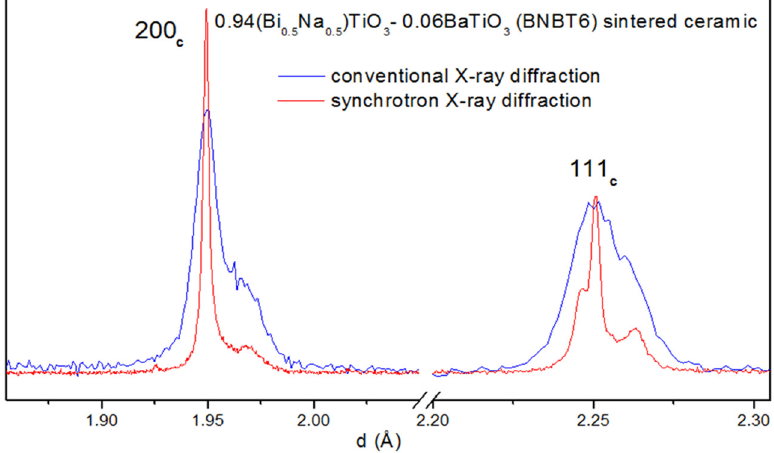
Figure 2. Diffraction peaks from sintered BNBT6 bulk ceramic from a powder flat specimen measured using a conventional Cu ‐ cathode X ‐ ray tube (step 0.05 2 θ ° and 5 s counting time) and synchrotron radiation at MCX beamline Elettra Sincrotrone, Trieste (Italy) (step 0.005 2 θ ° and 2 s counting time).